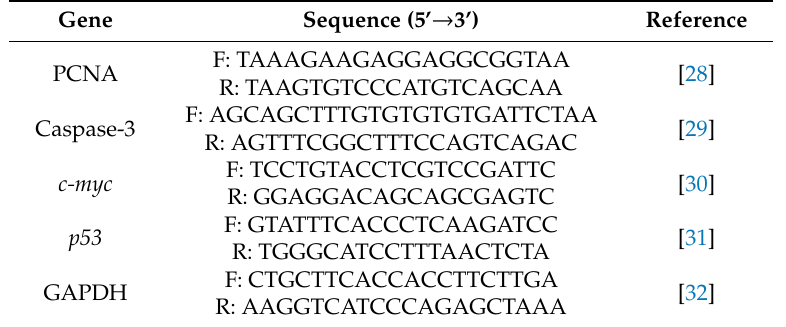
Table 1. Table of primer sequences of four genes associated with colorectal cancer (CRC) development. Gene Sequence (5’ → 3’) Reference F: PCNA